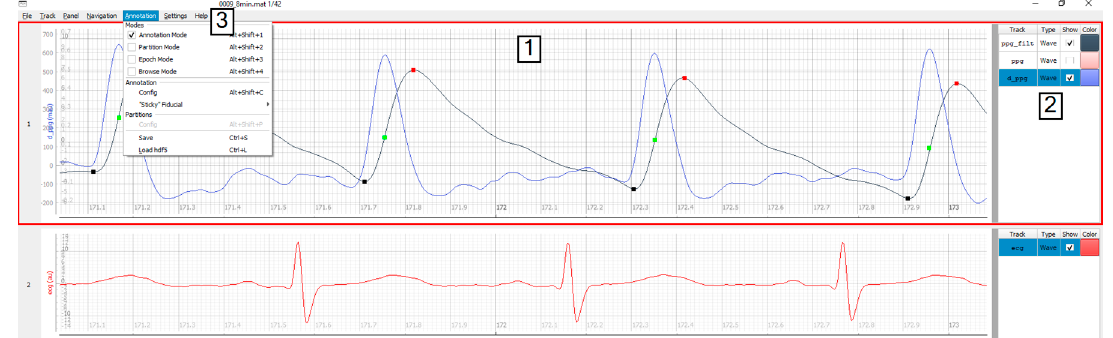
Figure 3. Main window: plot area (1) is split into two panels, plot controls (2) displaying three tracks, and the menu (3).